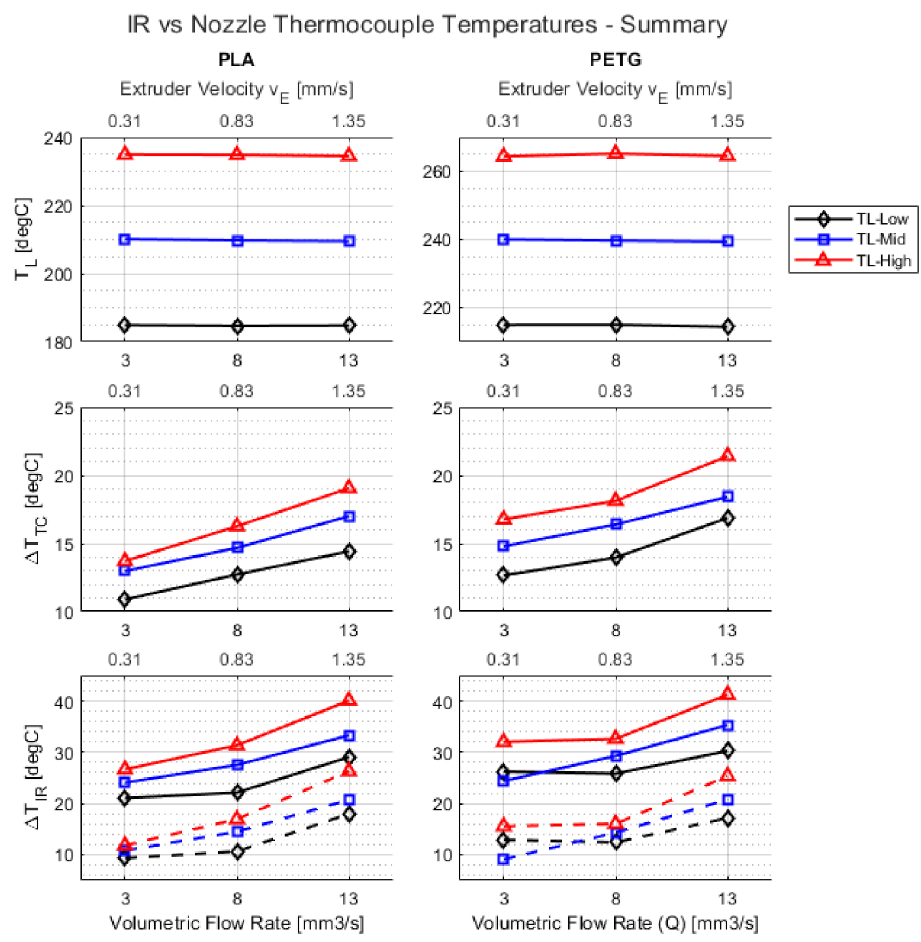
Figure 5. Summary of IR and nozzle thermocouple measurements averaged for all combinations of DOE runs. ∆ T TC = T L − T nz and ∆ T IR = T L − T IR . The dotted lines in the ∆ T IR plots represent T out = T IR = T nz measured with emissivity e = 0.82 calibrated based on the nozzle thermocouple while solid lines represent T out = T IR measured with emissivity e = 0.92 and calibrated based on existing literature. T L , T L , and T L are based on Table 1. Low mid high